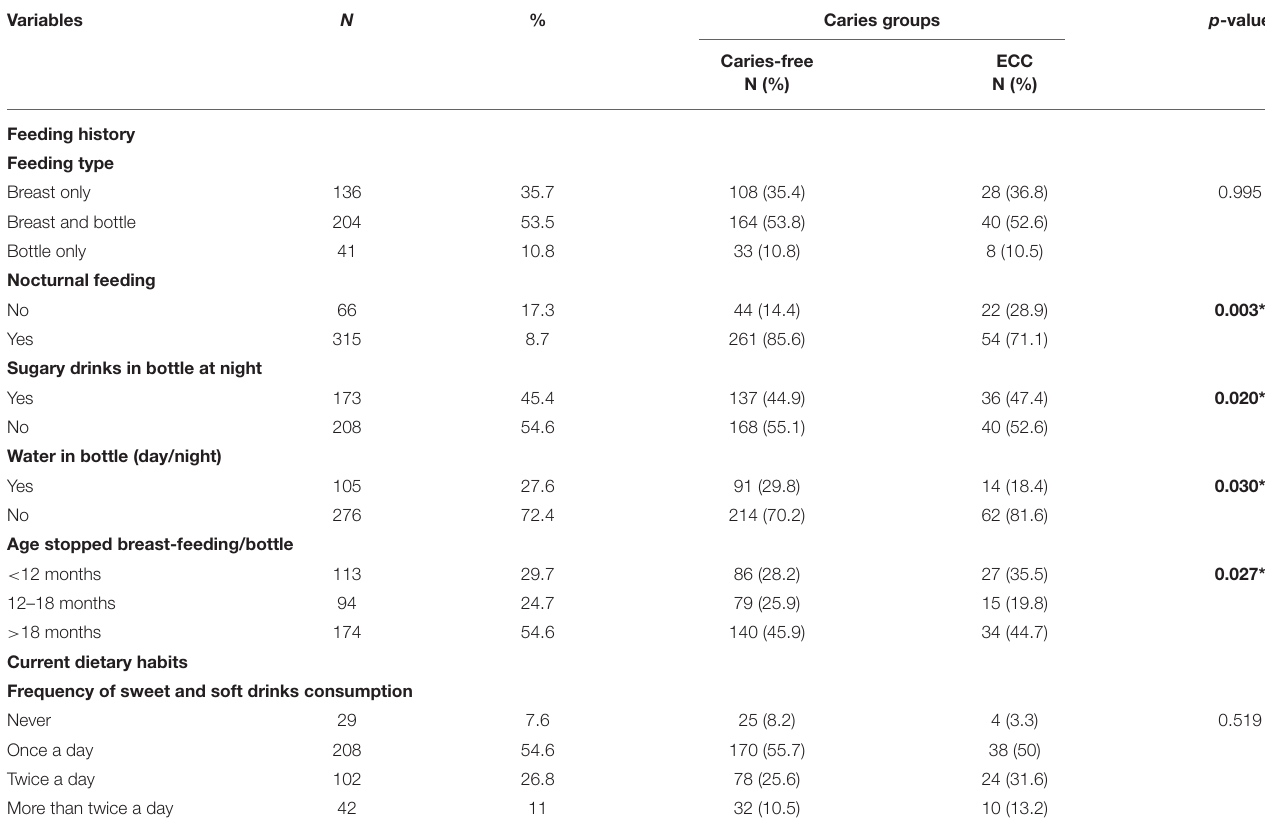
TABLE 2 | Prevalence of ECC and associated feeding history/dietary habits ( N = 381). Variables N % Caries groups p -value